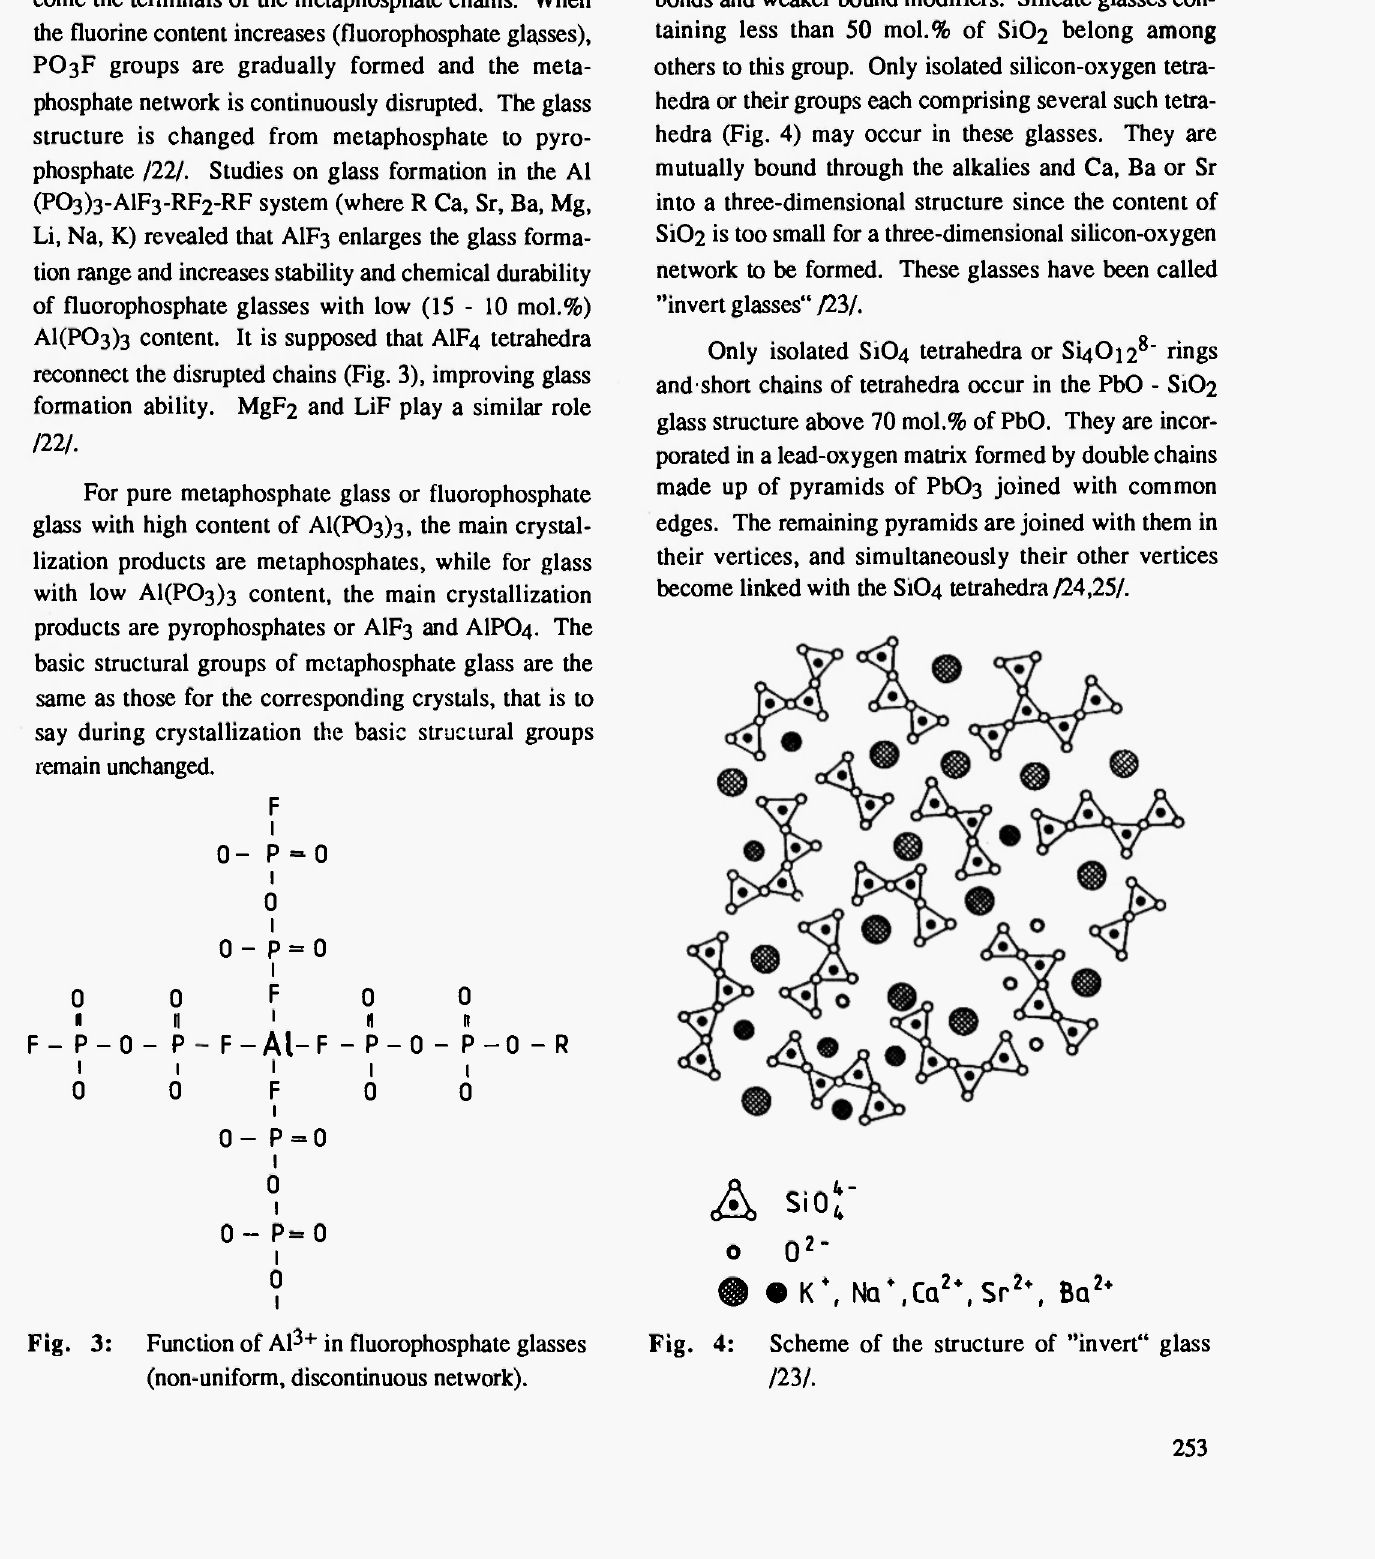
Fig. 4: Scheme of the structure of "invert" glass